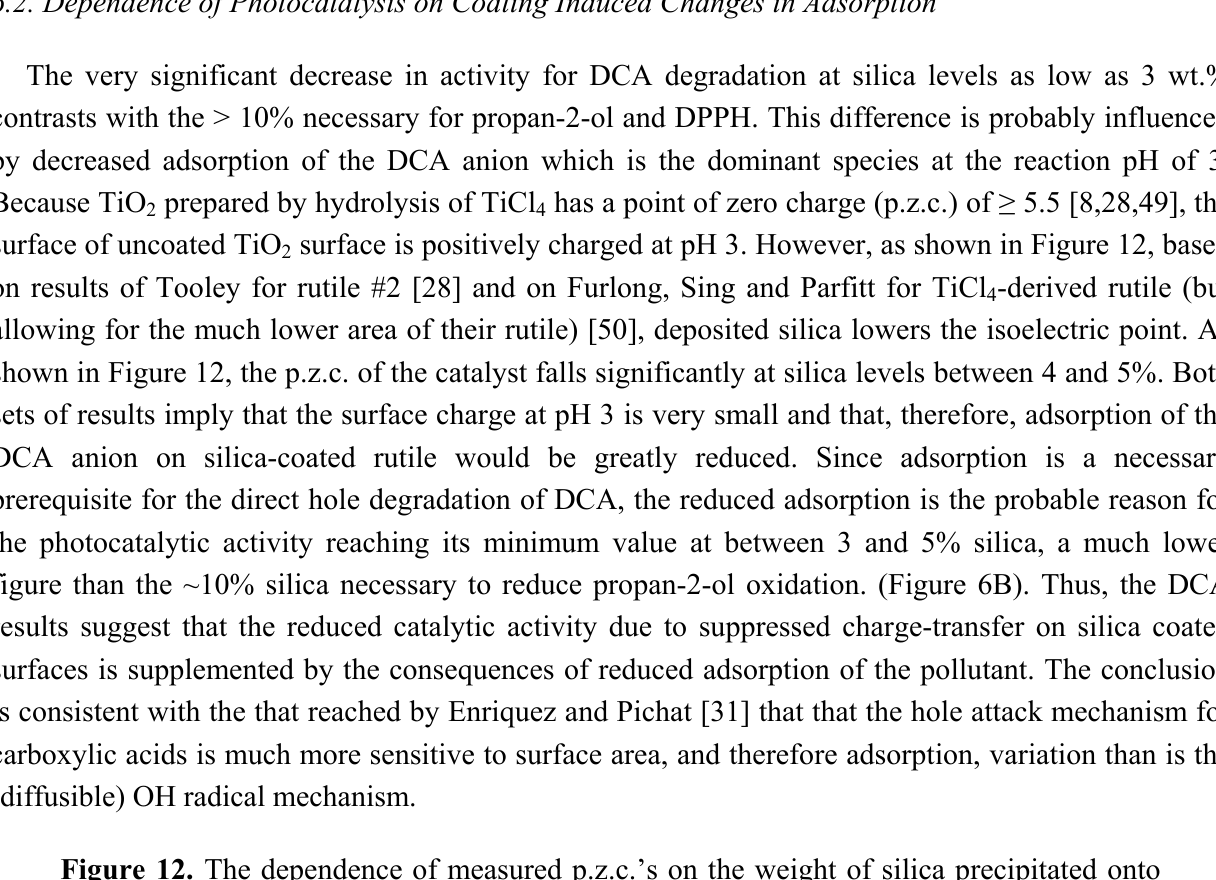
Figure 12. The dependence of measured p.z.c.’s on the weight of silica precipitated onto rutile #2 (130 m 2 g − 1 ) ■ . and p.z.c.’s measured by Furlong et al. [50], but “correcting”